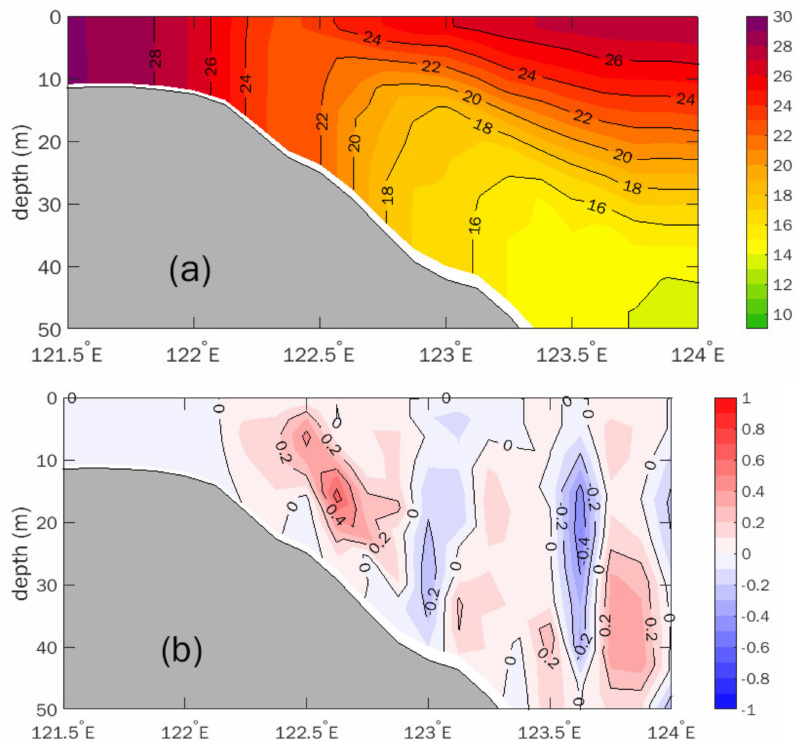
Figure 9. ( a ) Simulated temperature (unit: ◦ C) and ( b ) magnitude of vertical velocity along 33.5 ◦ N section in Exp.C on 11 August 2019 (unit: m/s). Positive and negative values refer to upward and downward current, respectively. Vertical velocity is magnified 1000